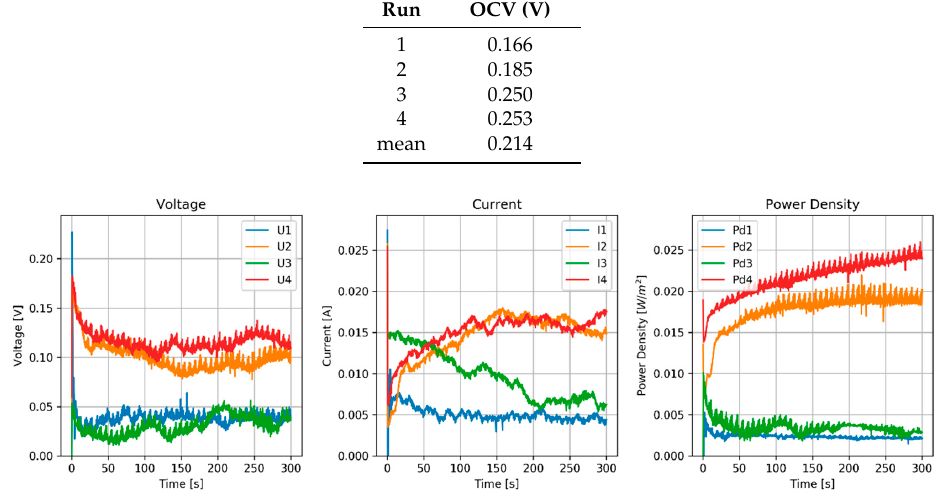
Figure 6. Results of the MPPT test of the RED stack equipped with normal AEMs (AMX) and pseudo CEMs (Zn).